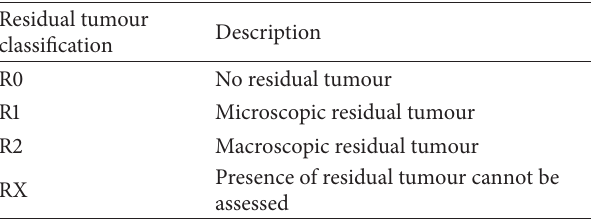
Table 2: Residual tumour classification from edge et al.; AJCC cancer staging manual